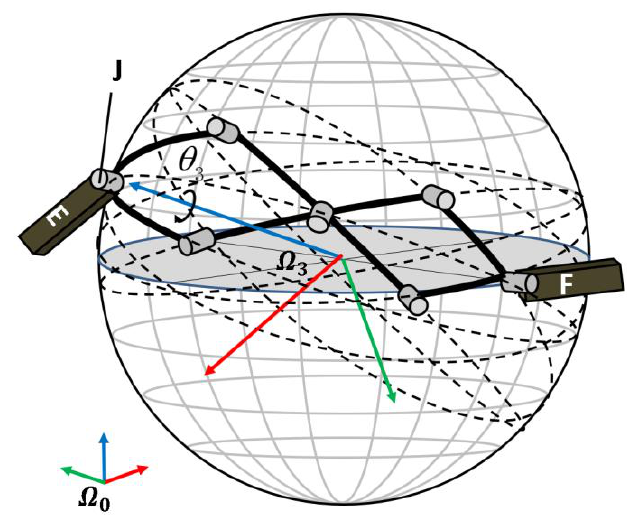
Figure 10. Frame rotation with the flexion/extension motion.